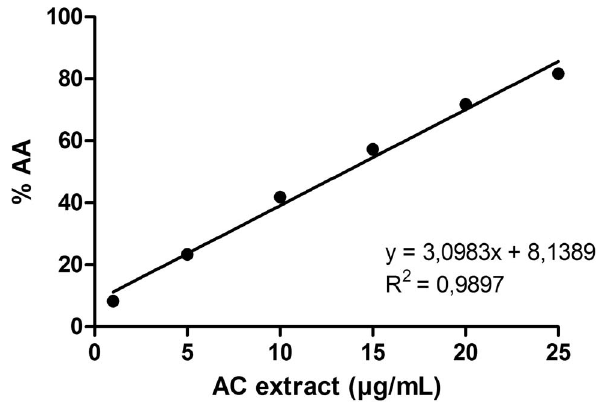
Figure 3. DPPH radical scavenging capacity of Arrabidaeachica (AC) extract. R 2 =0.9897.